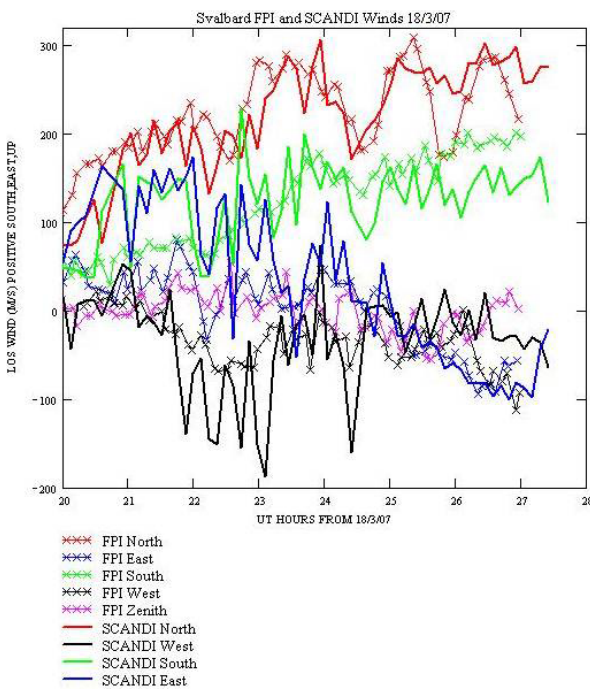
Fig. 16. SCANDI line-of-sight winds on the night of 18 March 2007 show a good match with FPI los winds from corresponding look directions. However, clear spatial structure may be seen in the wind field with a scale-size of the order of around